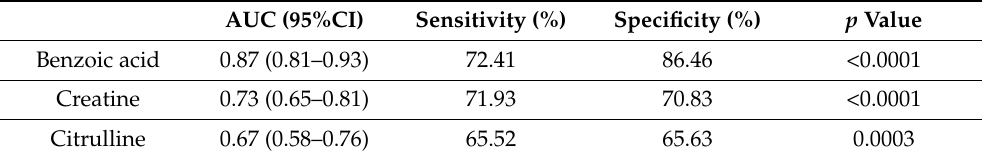
Figure 5. The diagnostic performance of benzoic acid, creatine, and citrulline in the validation cohort. ( A ) The levels of serum benzoic acid in NC, T2DM, T2DM(+) HCC, and T2DM( − ) HCC individuals in the validation cohort. ( B ) The levels of serum creatine in NC, T2DM, T2DM(+) HCC, and T2DM( − ) HCC individuals in the validation cohort. ( C ) The levels of serum citrulline in NC, T2DM, T2DM(+) HCC, and T2DM( − ) HCC individuals in the validation cohort. ( D ) The ROC curve of benzoic acid for discriminating T2DM(+) HCC patients from T2DM patients. ( E ) The ROC curve of creatine for discriminating T2DM(+) HCC patients from T2DM patients. ( F ) The ROC curve of citrulline for discriminating T2DM(+) HCC patients from T2DM patients. NC, normal control; T2DM, type 2 diabetes mellitus; HCC, hepatocellular cancer; ROC, receiver operating characteristic. * p value < 0.05; ** p value < 0.01; *** p value < 0.001; ns, not significant. Table 3. The diagnostic performance of benzoic acid, creatine, and citrulline for the detection of T2DM(+) HCC in a T2DM